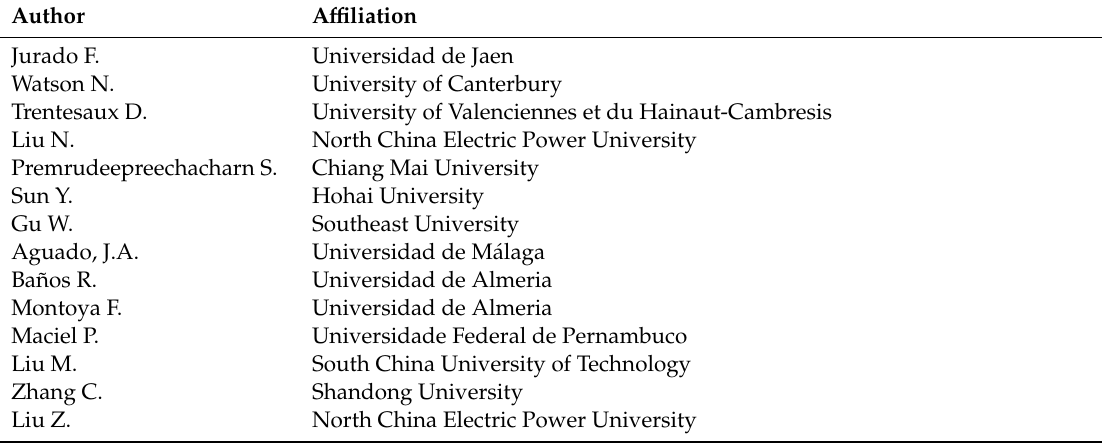
Table 2. A ffi liations and bibliometric indicators for the